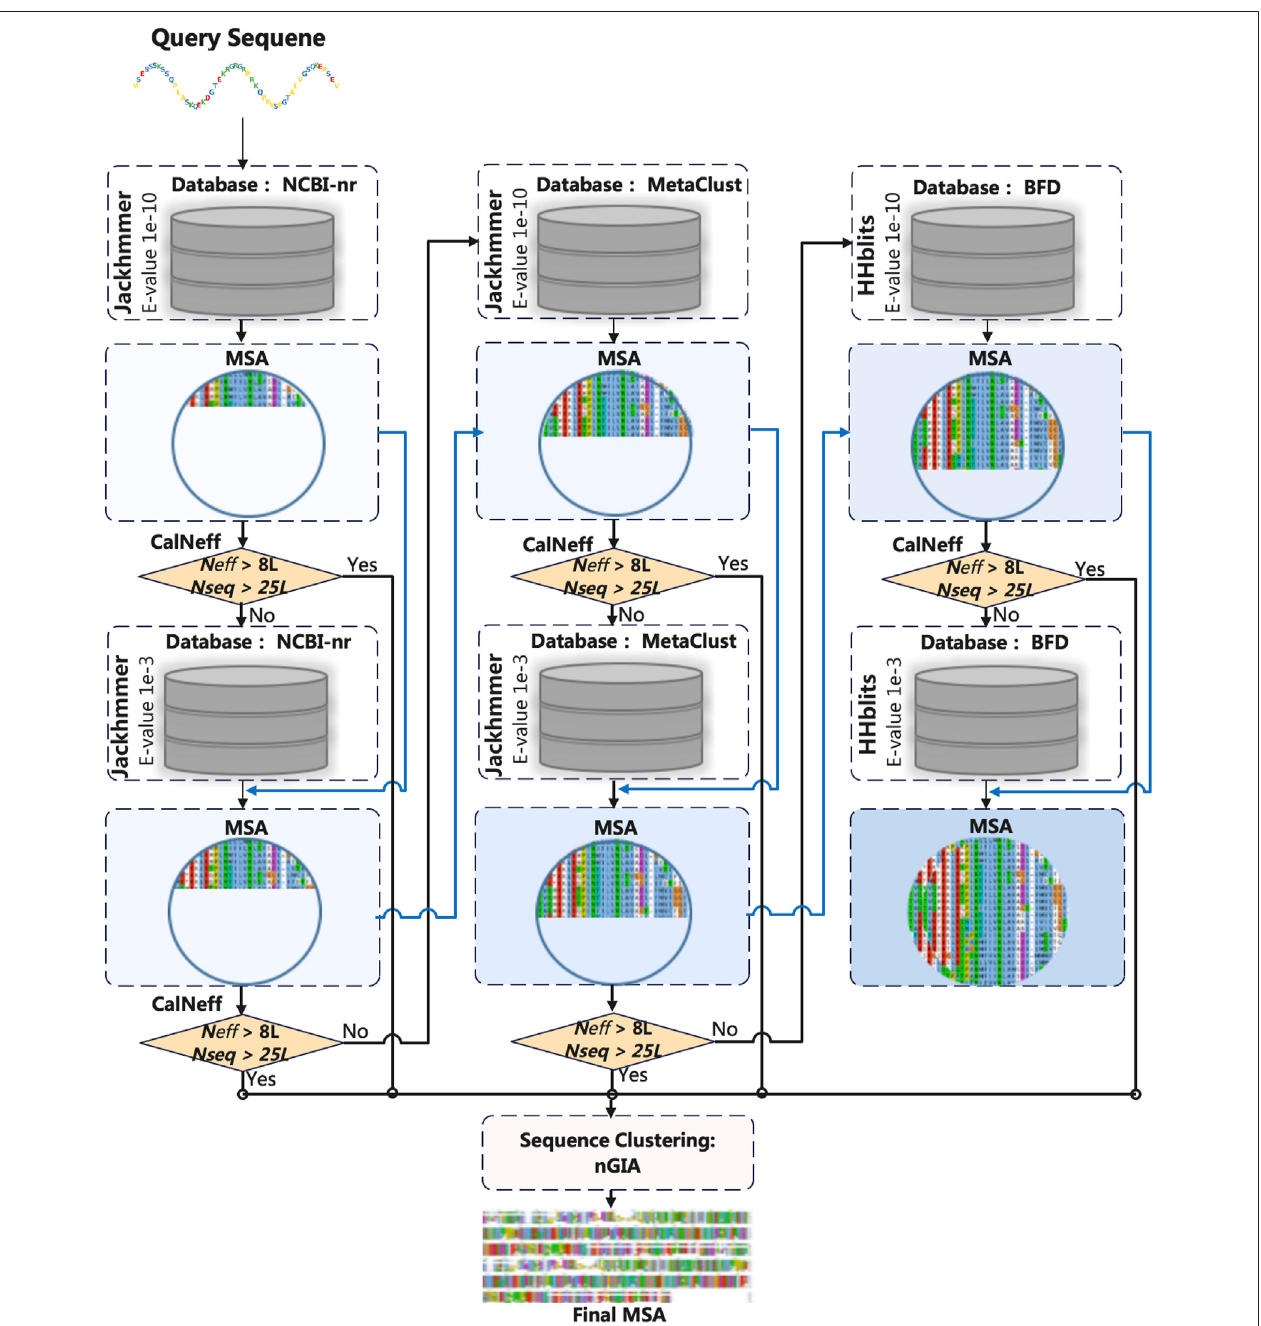
FIGURE 1 | The fl owchart of MSA generation for the training